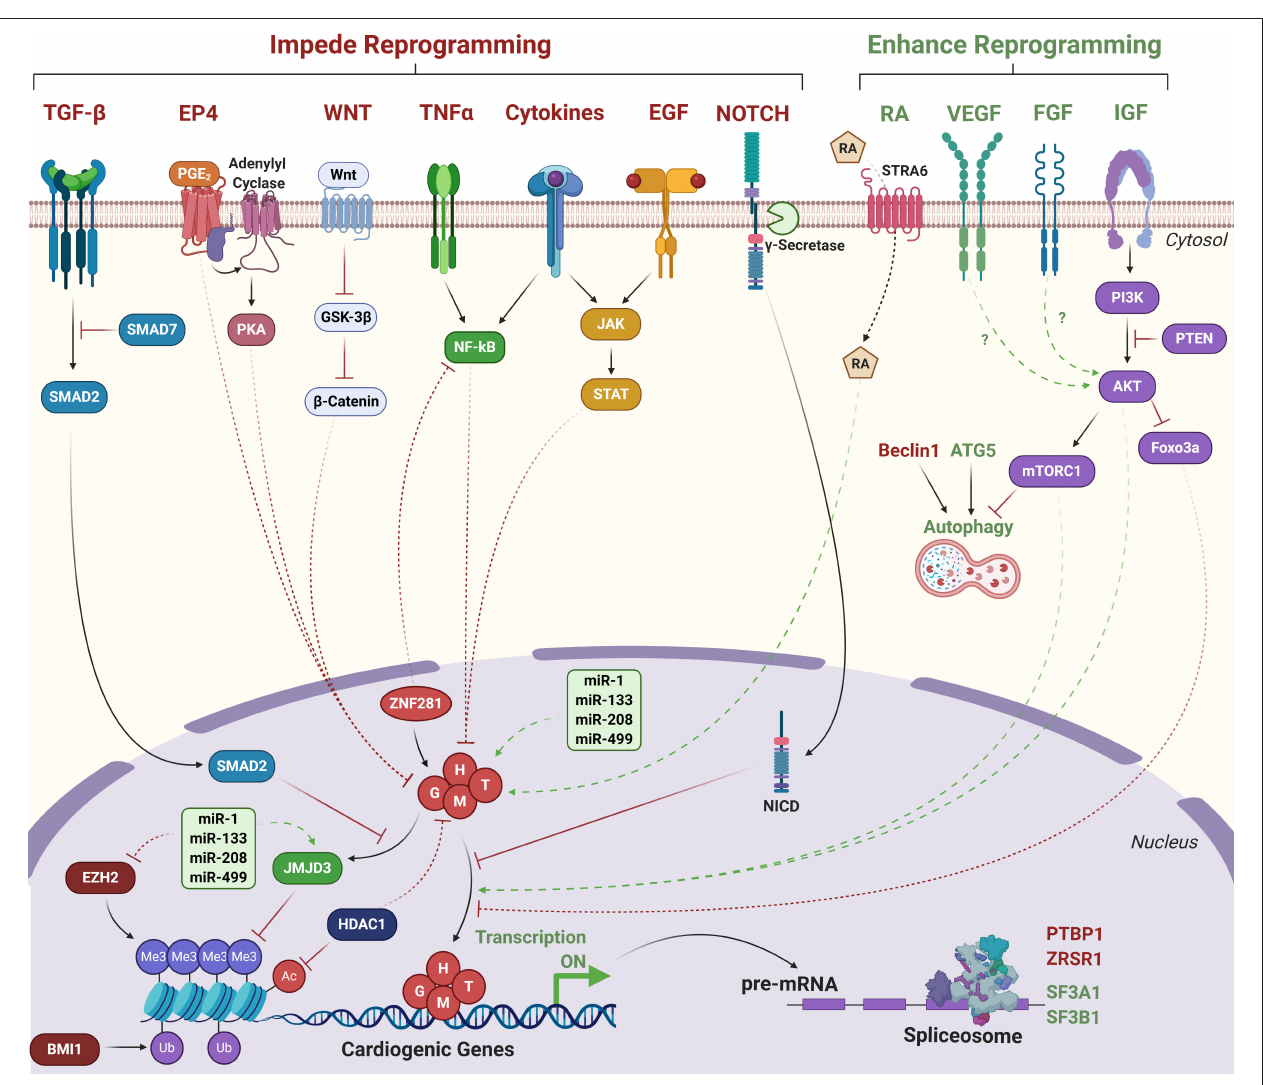
FIGURE 3 | Signaling pathways that influence direct cardiac reprogramming. Green text/arrows indicate pathways that enhance reprogramming. Red text/arrows indicate pathways that negatively regulate reprogramming. Solid lines indicate direct interactions. Dashed lines indicate indirect or hypothesized interactions. G, H, M, T, GATA4, HAND2, MEF2C, TBX5; RA, Retinoic acid; NICD, Notch intracellular domain. Transcriptionally repressive histone marks: Me3; H3K27me3. Ub; H2AK119 ubiquitination. Transcriptionally activating histone marks: Ac, histone